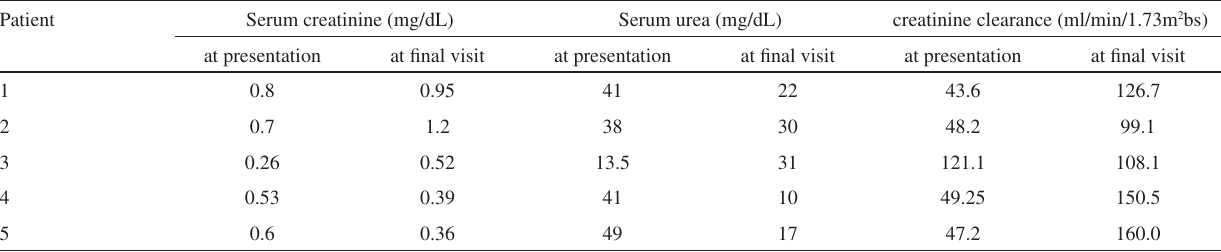
Table 2 - Laboratory findings Patient